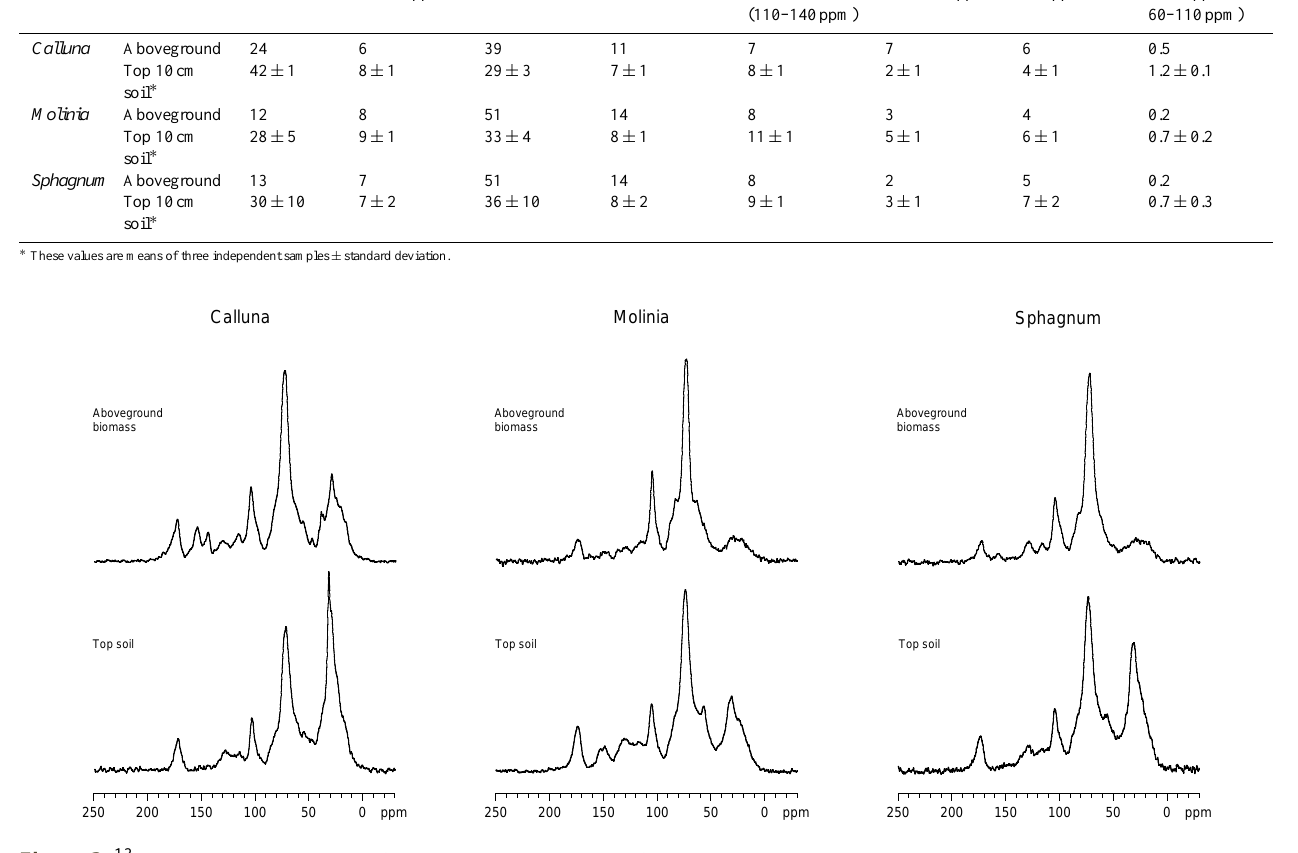
increased their relative N content from November to